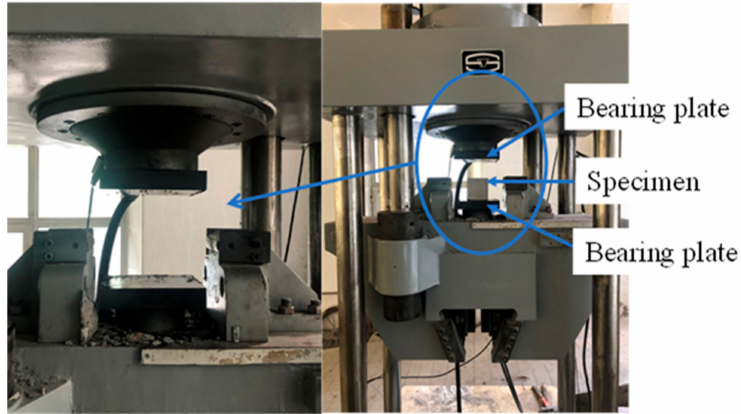
Figure 4. Microcomputer controlled electrohydraulic servo universal testing